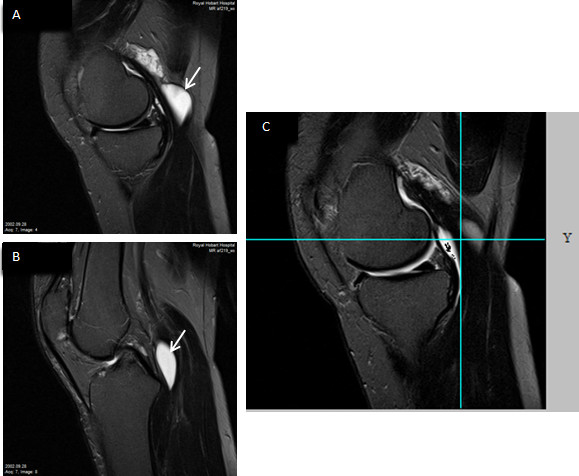
Simultaneous presence of a popliteal cyst (Baker cyst) and subgastrocnemius bursitis in a right knee. A grade-3 popliteal cyst (arrow) was superficially located adjacent to the medial head tendon of the gastrocnemius (A); also a grade-3 subgastrocnemius bursitis (arrow) was shown between the capsule and medial head of the gastrocnemius (B); the popliteal cyst and subgastrocnemius bursitis were separated but communicated with each other in the multiplanar view in the sagittal plane (C).